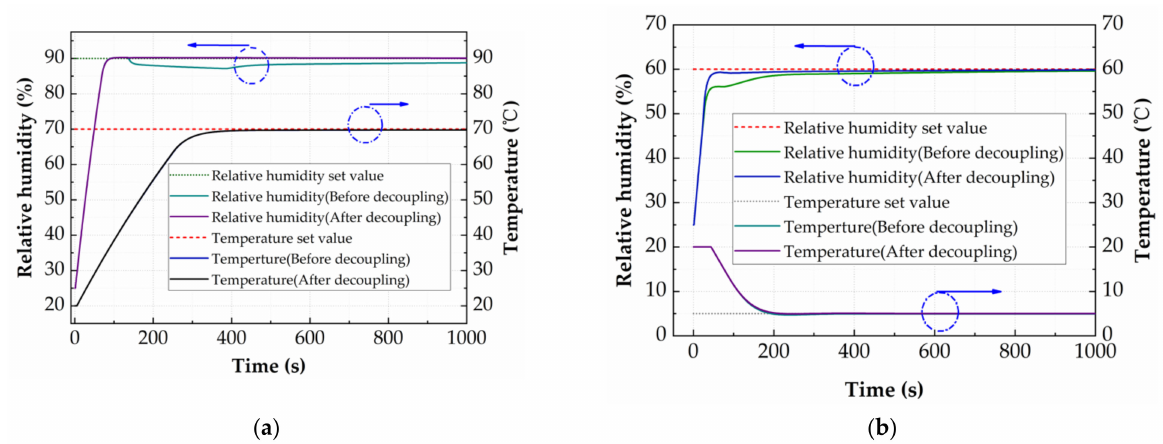
Figure 8. ( a ) Response curve of heating-humidifying system before and after decoupling. ( b ) Response curve of cooling- humidifying system before and after